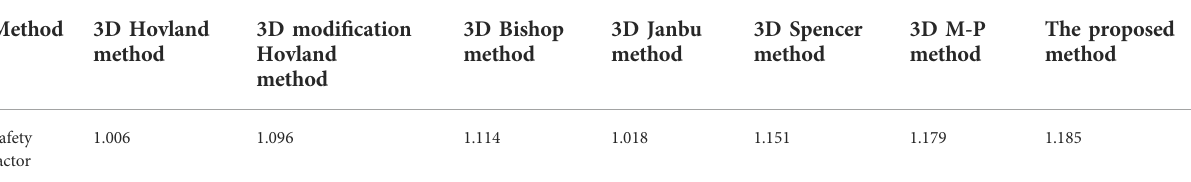
TABLE 2 Calculation